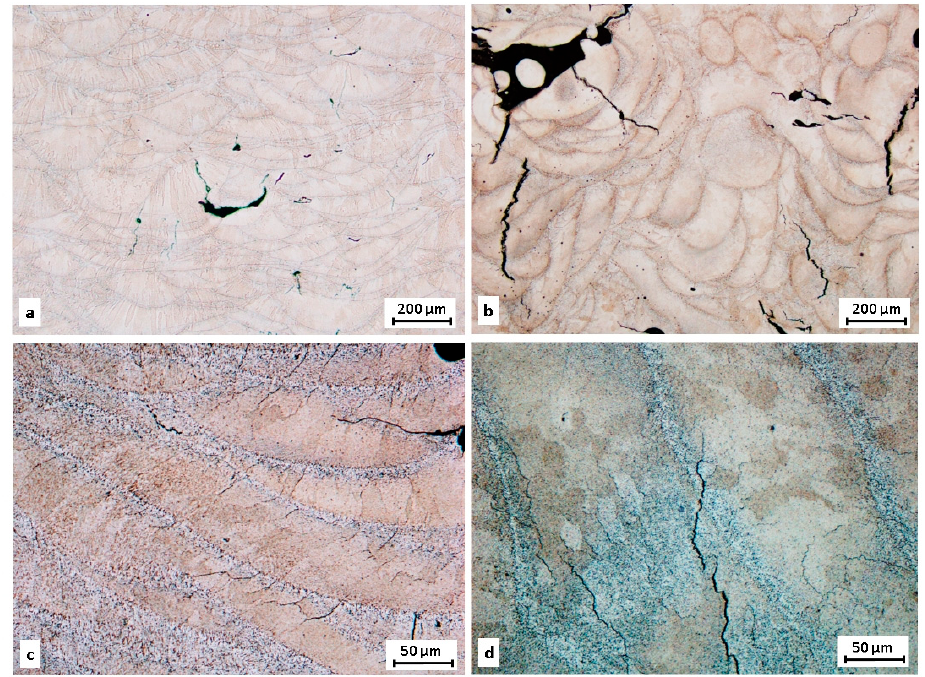
Figure 16. Microstructure of SLM state material fabricated with meander strategy; ( a , c ) transverse direction; ( b , d ) longitudinal direction.